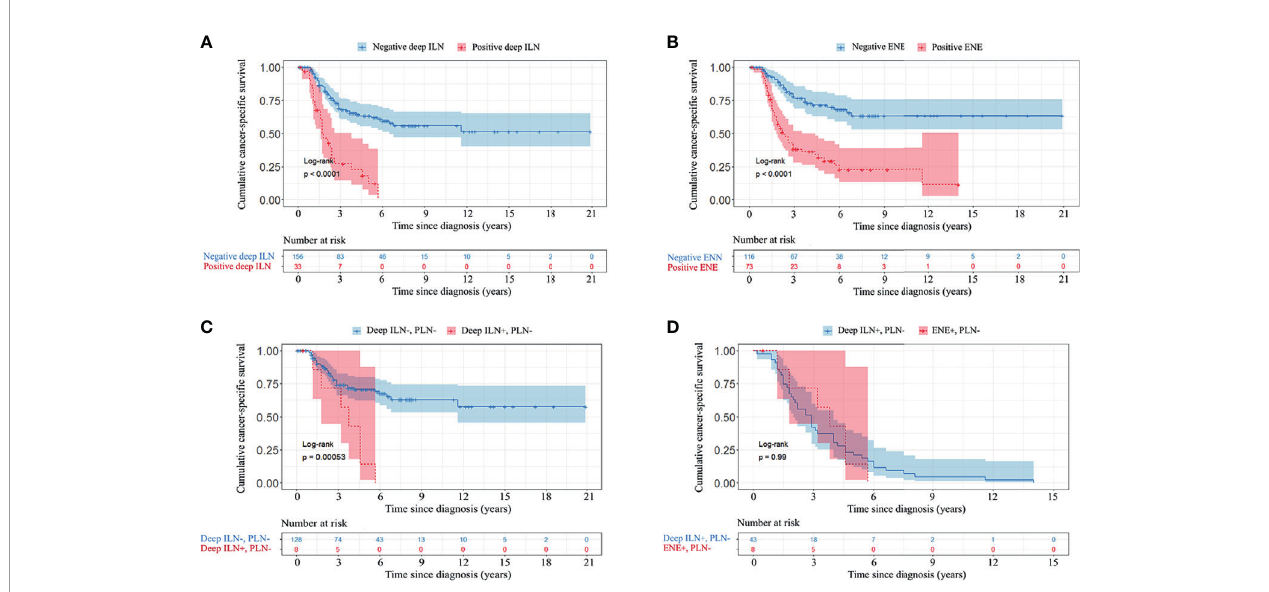
FIGURE 3 | Kaplan-Meier CSS curve of patients with different ILN and PLN characteristics. (A) , deep ILN. (B) , ENE. (C) , deep ILNM without PLNM. (D) , deep ILNM and ENE without PLNM. CSS, cancer-speci fi c survival; PLN, pelvic lymph node; ILN, inguinal lymph node; ENE, extranodal